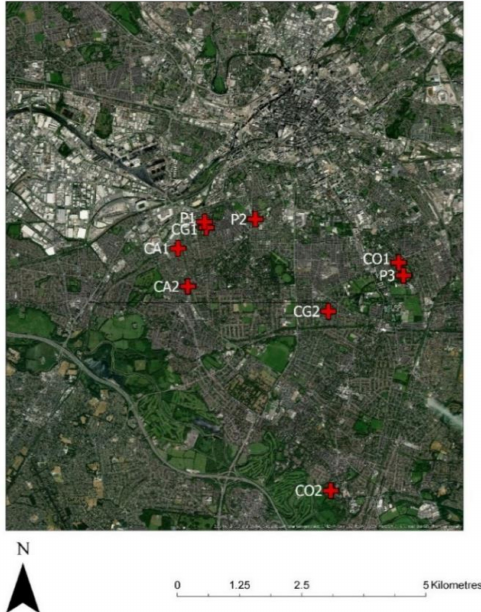
Figure 1. Locations of the study sites (sources: Esri, DigitalGlobe, GeoEye, i-cubed, USDA FSA, USGS, AEX, Getmapping, Aerogrid, IGN, IGP, swisstopo, and the GIS User